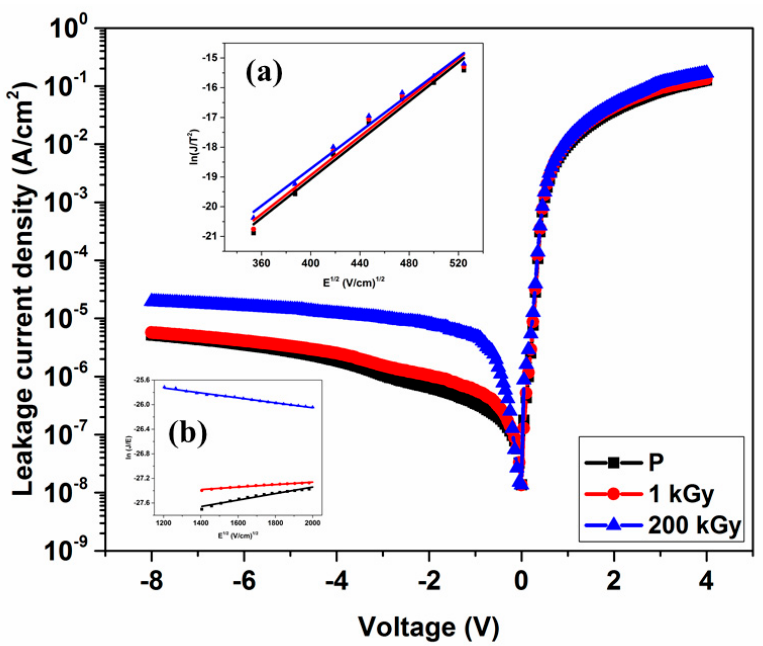
Figure 10. Current–Voltage characteristics of HfO 2 / β -Ga 2 O 3 MOSCAPs at various doses. Inset ( a ): ( a ): ln( J / T 2 ) vs. E 1/2 for 0.65 ≤ E ≤ 2.0 MV cm − 1 , and inset ( b ): ln( J / E ) vs. E 1/2 . Reprinted/adapted ln (J/T 2 ) vs E 1/2 for 0.65 ≤ E ≤ 2.0 MV cm − 1 , and inset ( b ): ln (J/E) vs E 1/2 . Reprinted/adapted with per- with permission from Ref. [86], 2020, IOP mission from Ref. [86], 2020, IOP Publishing.